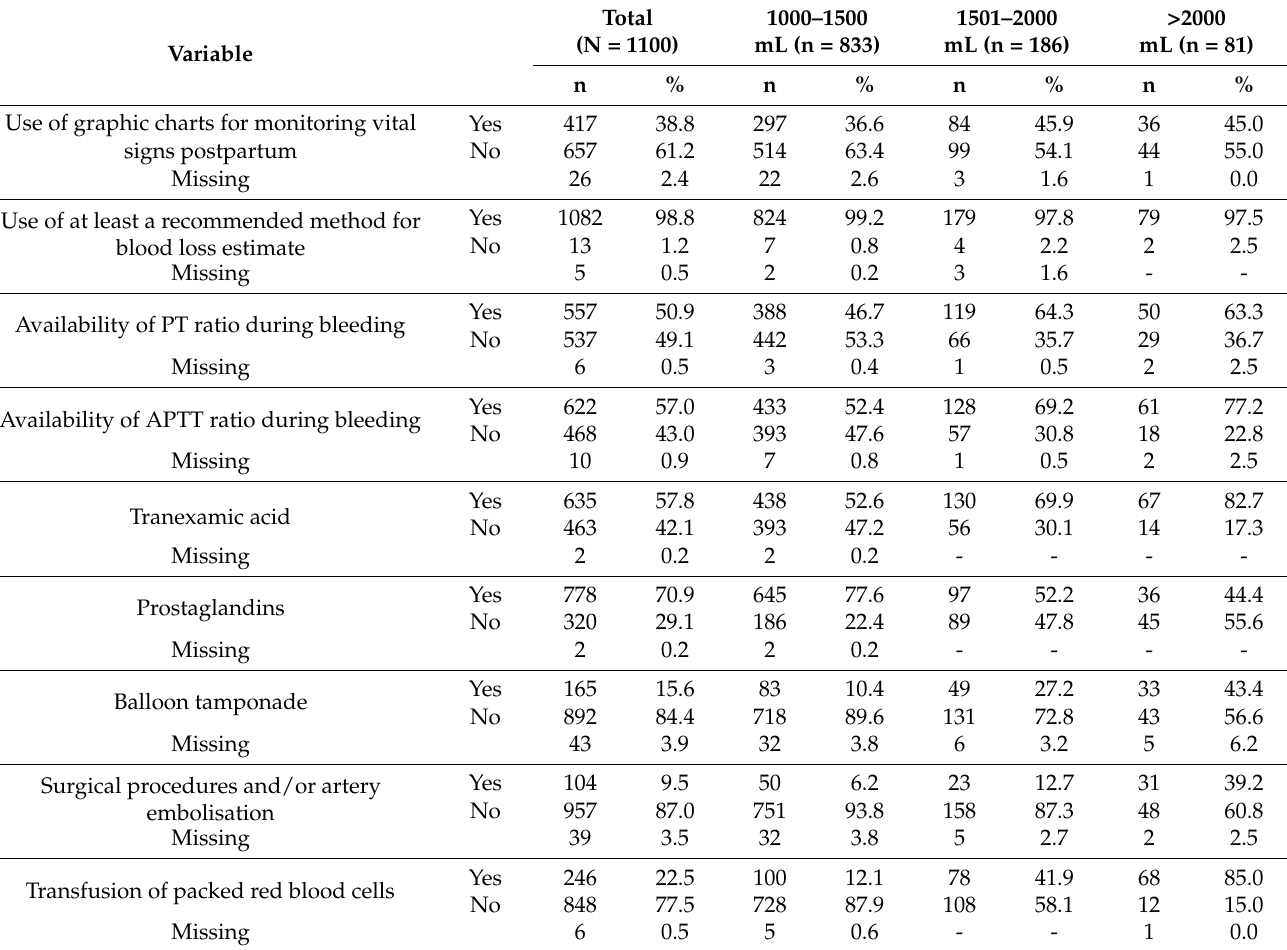
Table 3. Management of postpartum haemorrhage cases by blood loss